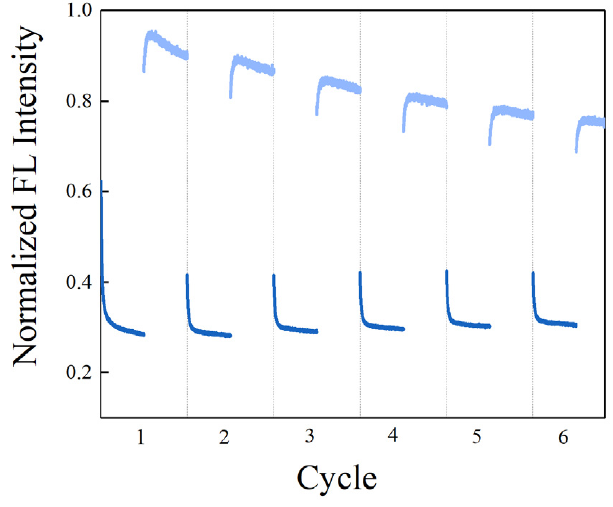
Figure 10. Regeneration of the SITS-Thrombin27 5 ′ aptasensor in the presence of thrombin. The sam- ple was excited at ex/em = 333 nm/426 nm ( trans to cis ) for 60 s followed by ex/em = 280 nm/426 mm ( cis to trans ) for 60 s for 6 cycles as illustration.